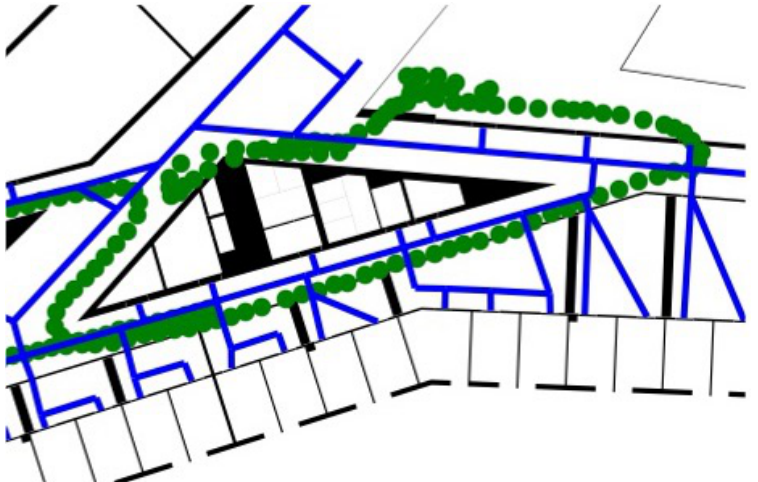
Figure 12. Effect of the support through the weighting by routing support on the deviated